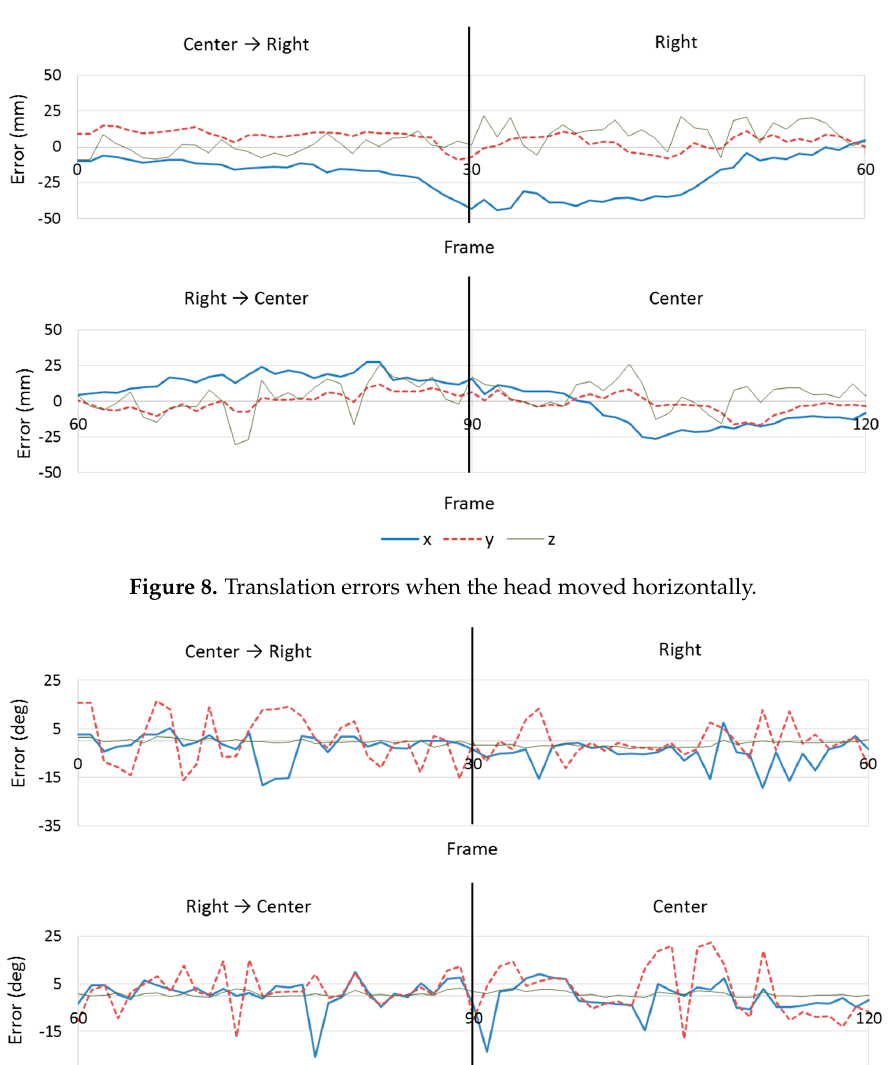
Figure 7. Experimental setup for evaluating registration accuracy. Six degrees ‐ of ‐ freedom (6 ‐ DOF) errors between the AR marker and the projected circles are measured.